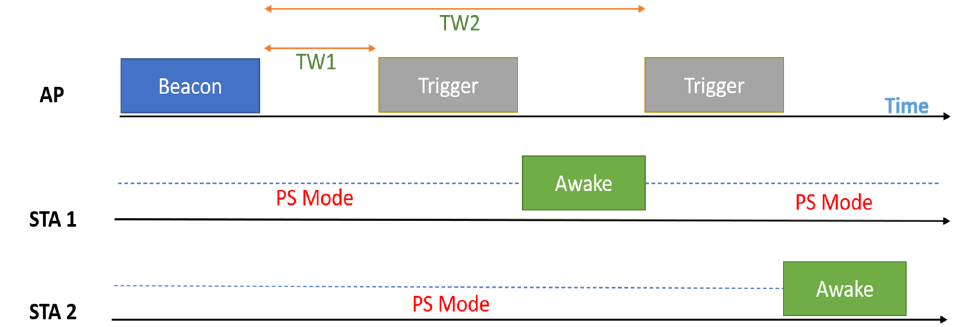
Figure 4. 802.11e PS Frame Exchange.